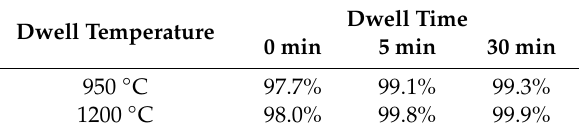
Table 3. Density of swarf specimens after FAST processing at the indicated conditions. Dwell